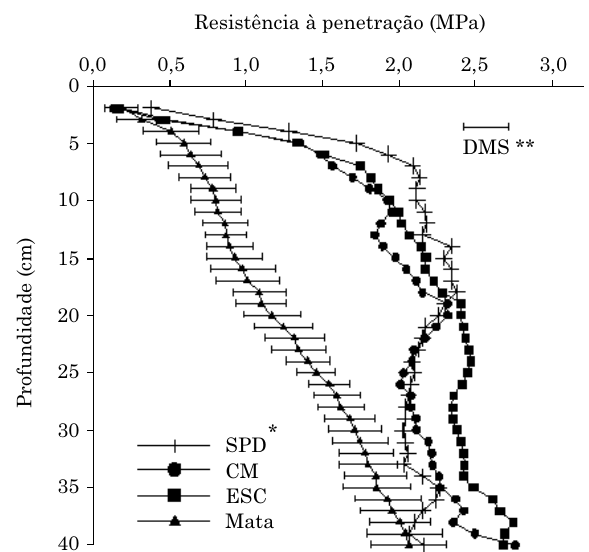
Figura 1. Resistência à penetração de um Latossolo Vermelho sob diferentes sistemas de manejos e em mata nativa, Taquaruçu do Sul, RS, em que *SPD: sistema plantio direto; CM: cultivo mínimo; ESC: escarificação; e ** DMS: diferença mínima significativa (teste t,